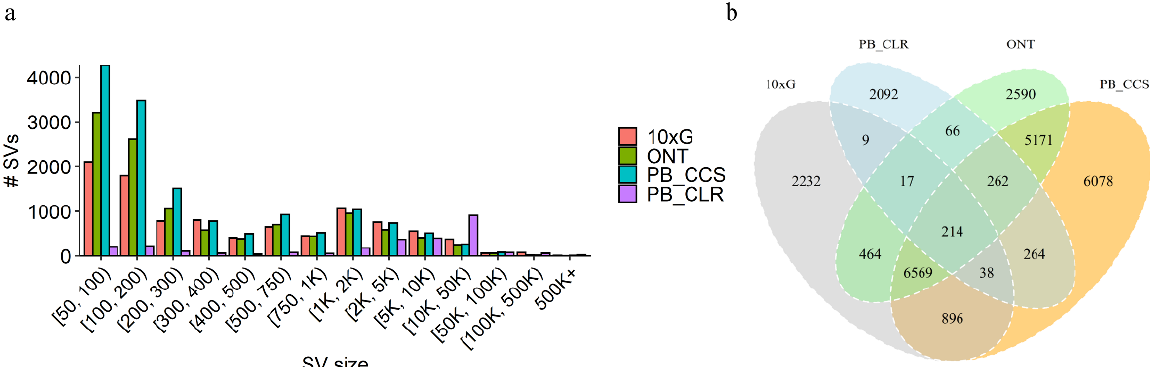
Figure 3. ( a ) Size distribution for SVs inferred from either long reads or Illumina/10 × G short reads. ( b ) Comparison between the four SV datasets.